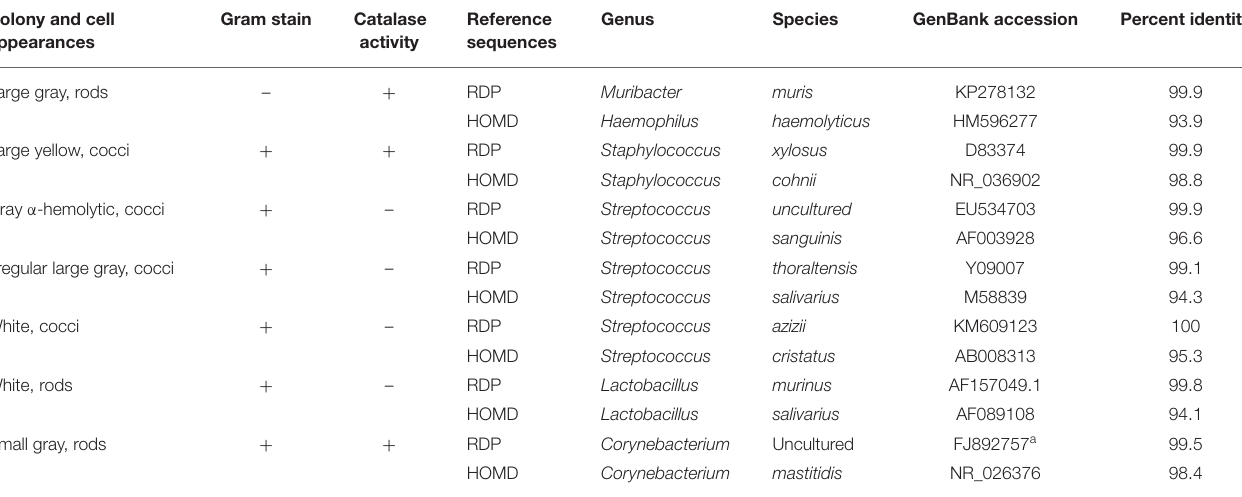
TABLE 2 | Phenotypic characteristics and 16S rRNA sequence alignments of colonies isolated on blood agar from oral swabs of wild-type and Amy1 knockout mice under aerobic